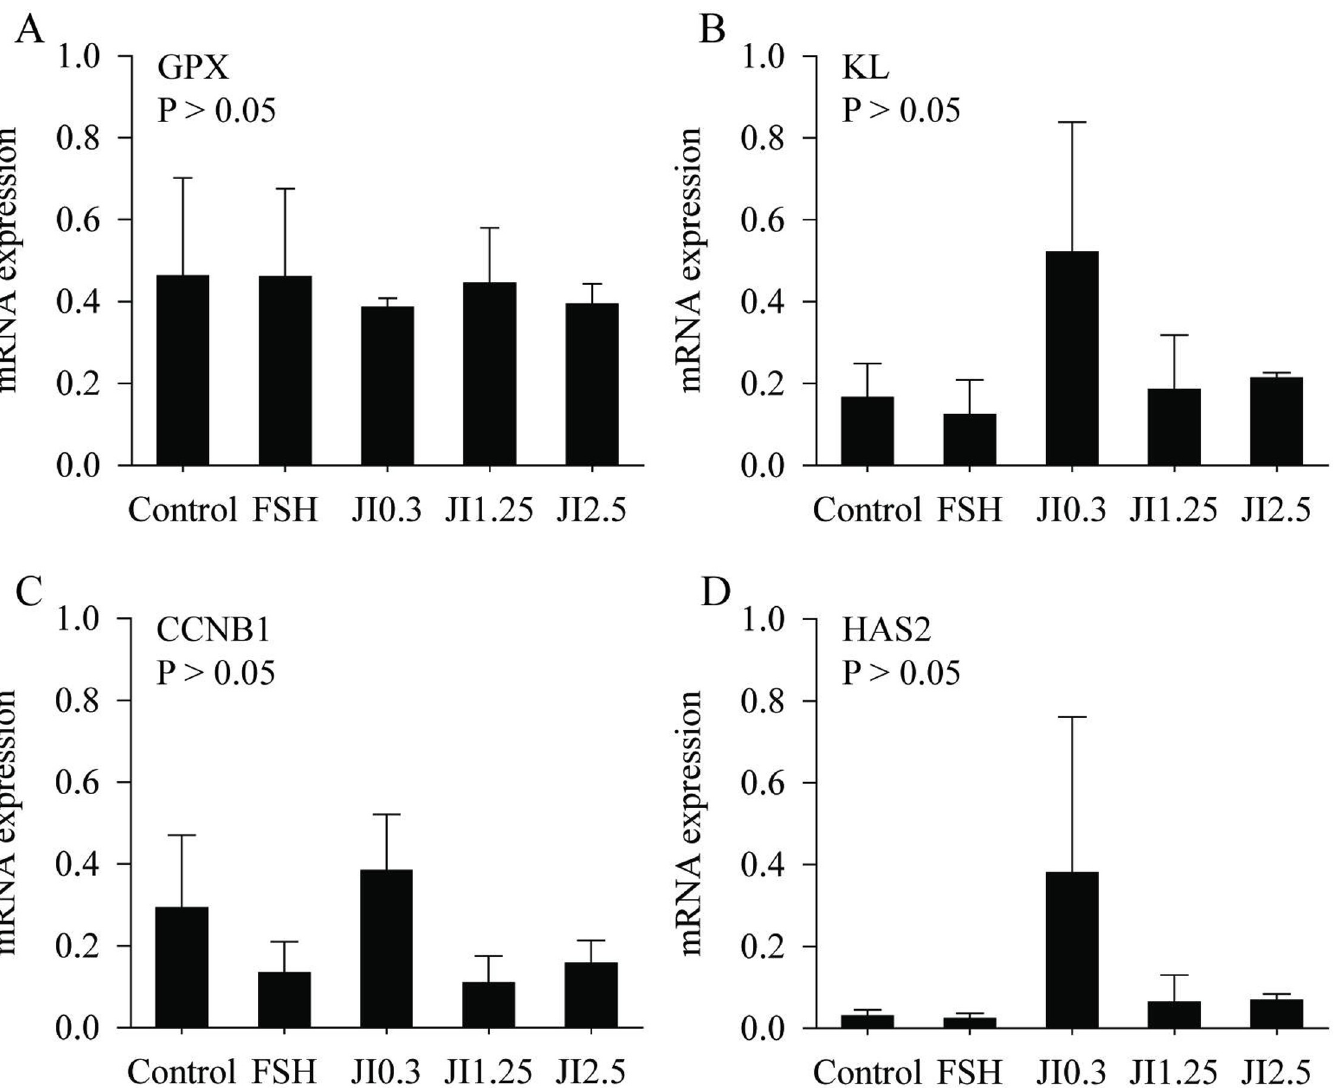
Fig 6. Relative mean (standard error of the mean) expression of mRNA of GPX (A), KL (B), CCNB1 (C), and HAS2 (D) before (D0) and during 18 days of in vitro culture (D6, D12, D18) in MEM + (Control), FSH or in JI0.3, JI1.25 or JI2.5 . A,B Different letters denote significant differences among treatments (P < 0.05).